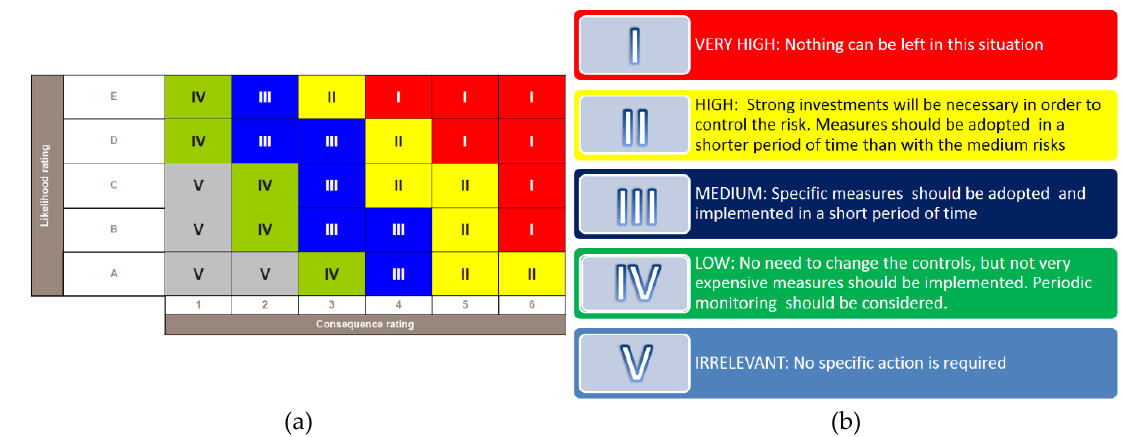
Figure 4. ( a ) Probability criteria matrix (likelihood versus consequence); ( b ) Risk levels assigned to the